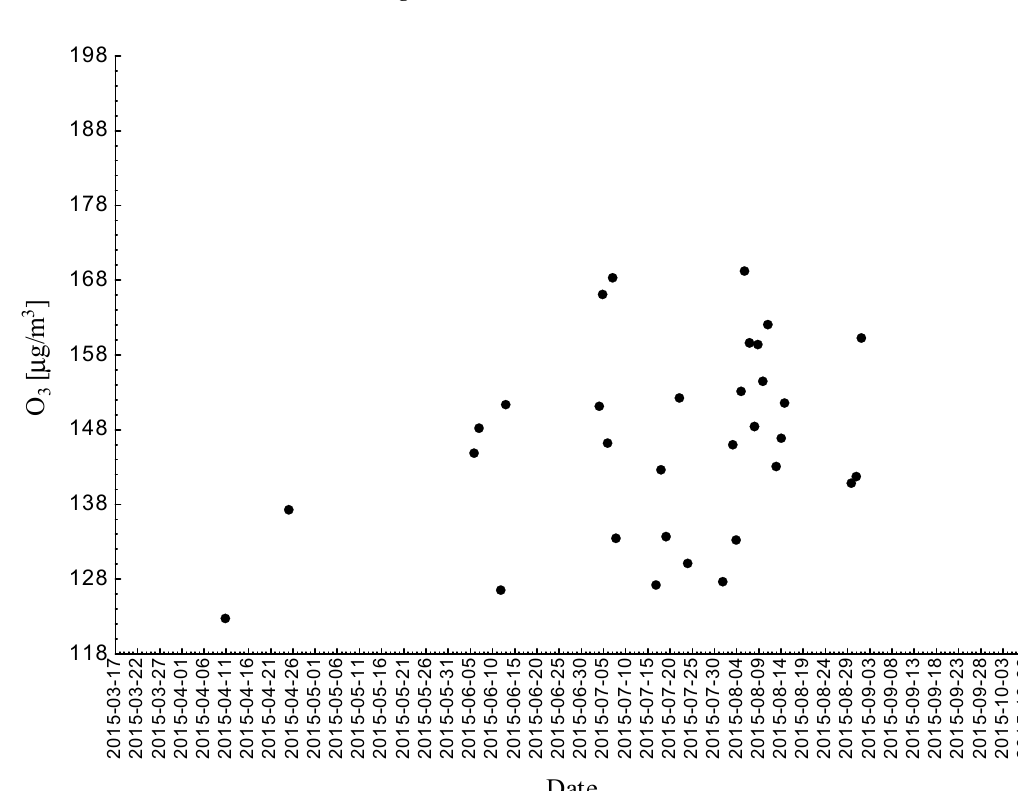
Figure 5. Maximum daily 8-h mean ozone concentration not less (equal to or more than) than 120.4 µg/m 3 registered at the measurement station in Katowice (SL09KA) in 2015.